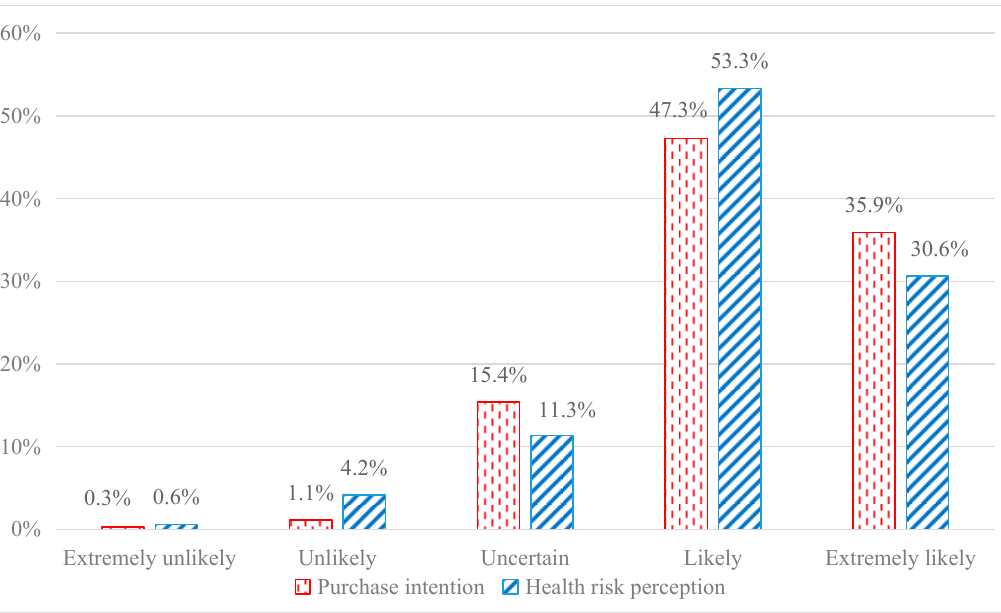
Figure 1. Purchase intention and health risk perception of consumers.